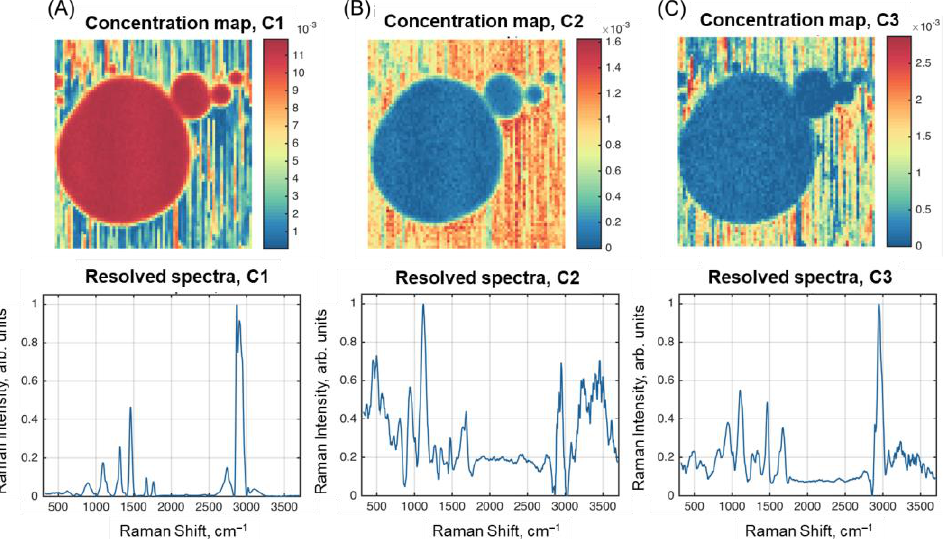
Figure 6. Results of spectral unmixing with ALS-MCR: resolved concentration maps and spectra of: ( A ) Component 1; ( B ) Component 2; ( C ) Component 3.